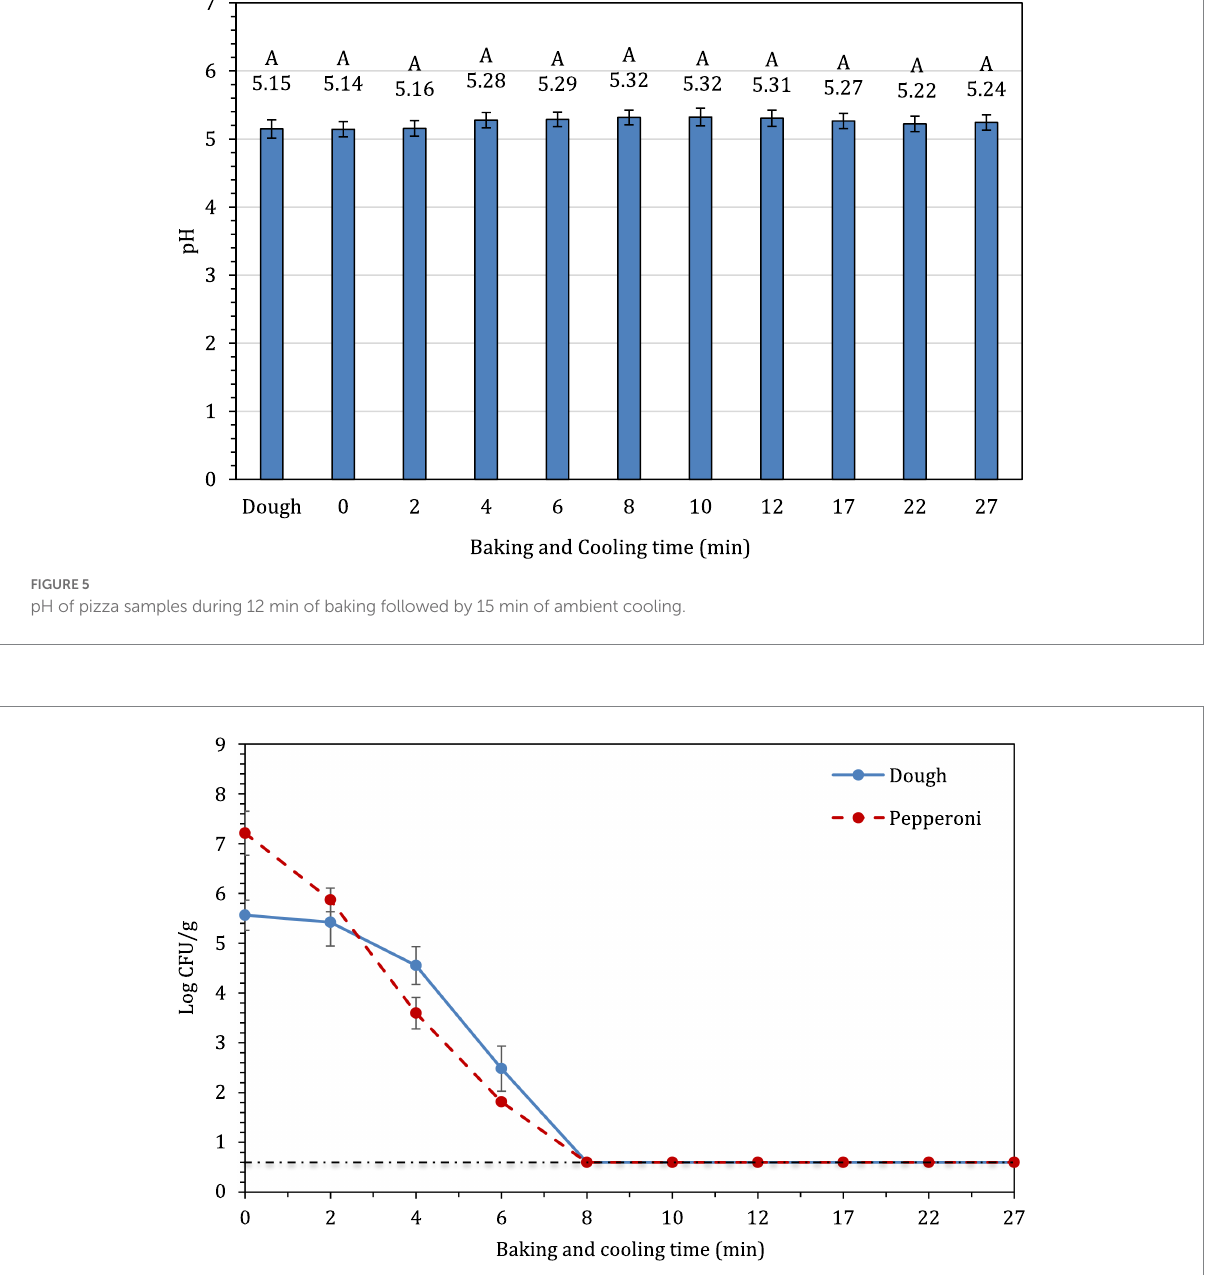
FIGURE 6 The log 10 reduction in STEC population in pizza dough or crust and pepperoni slices during 12 min of baking followed by 15 min of ambient